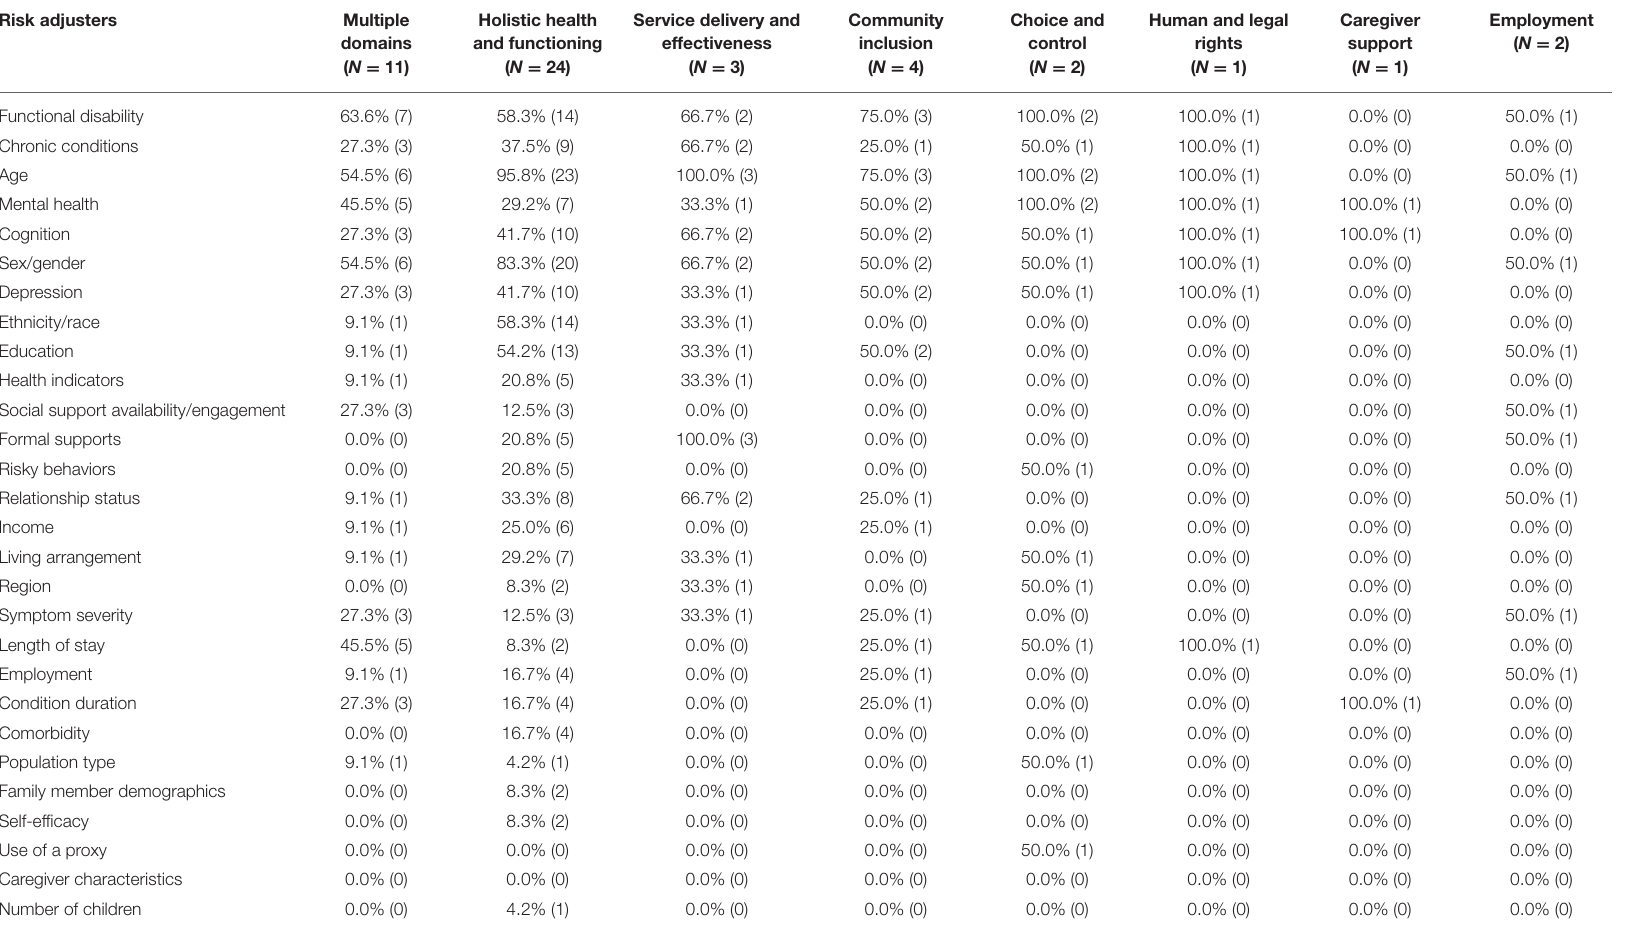
TABLE 5 | Percentages and frequency of risk adjusters used across NQF